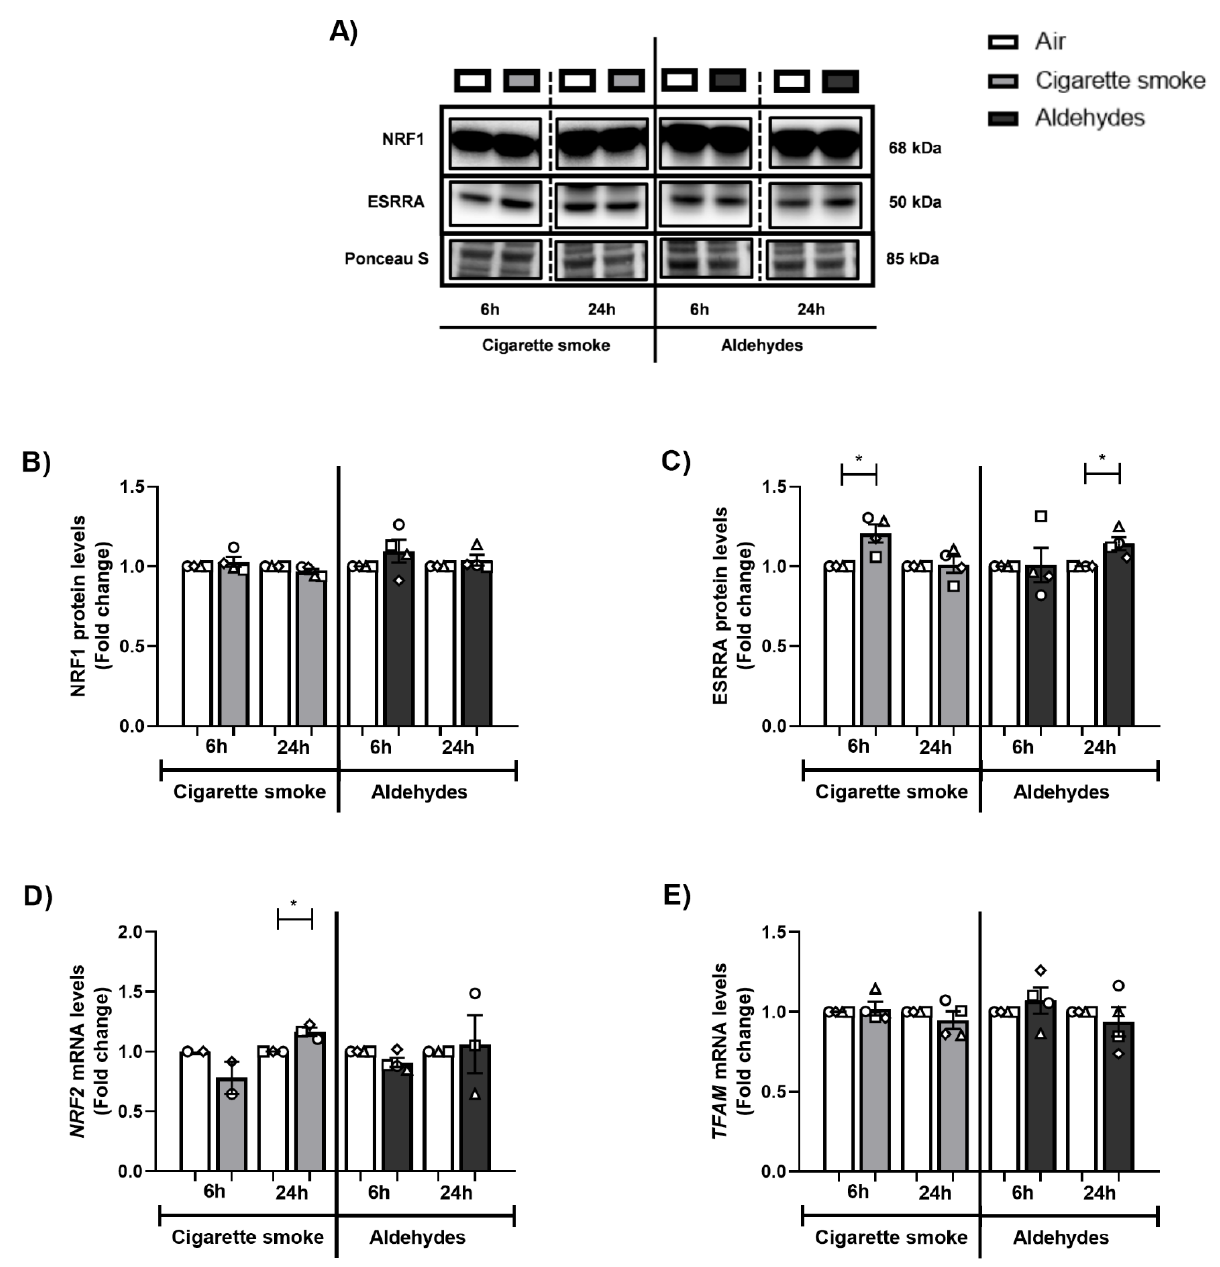
Figure 6. CS exposure results in changes in the abundance of PPARGC1-coactivated transcription factors. Differentiated human primary bronchial epithelial cells (PBEC) from non-COPD subjects ( n = 2–4 donors) were exposed to smoke of one Marlboro Red cigarette (CS), or a mixture of acetalde- hyde, acrolein, and formaldehyde (at concentrations equivalent to one cigarette), or air (control), in a continuous flow system using a puff-like exposure protocol. After recovery for 6h or 24h, whole cell lysates were harvested to analyze ( A ) protein levels of ( B ) NRF1 and ( C ) ESSRA. Representative Western blot images are shown for one replicate from one donor per experiment, reflective of the changes in all donors as quantified in the corresponding graph. Transcript levels of ( D ) NRF2 and ( E ) TFAM were analyzed. Data are presented as mean fold change compared to air control ± s.e.m. The mean values of biological triplicates per independent donor are represented by open circles, triangles, squares, or diamonds. Statistical differences between CS vs. air and a mixture of aldehydes vs. air were tested using a two-tailed paired parametric t -test. Statistical significance is indicated as * p < 0.05 vs. air